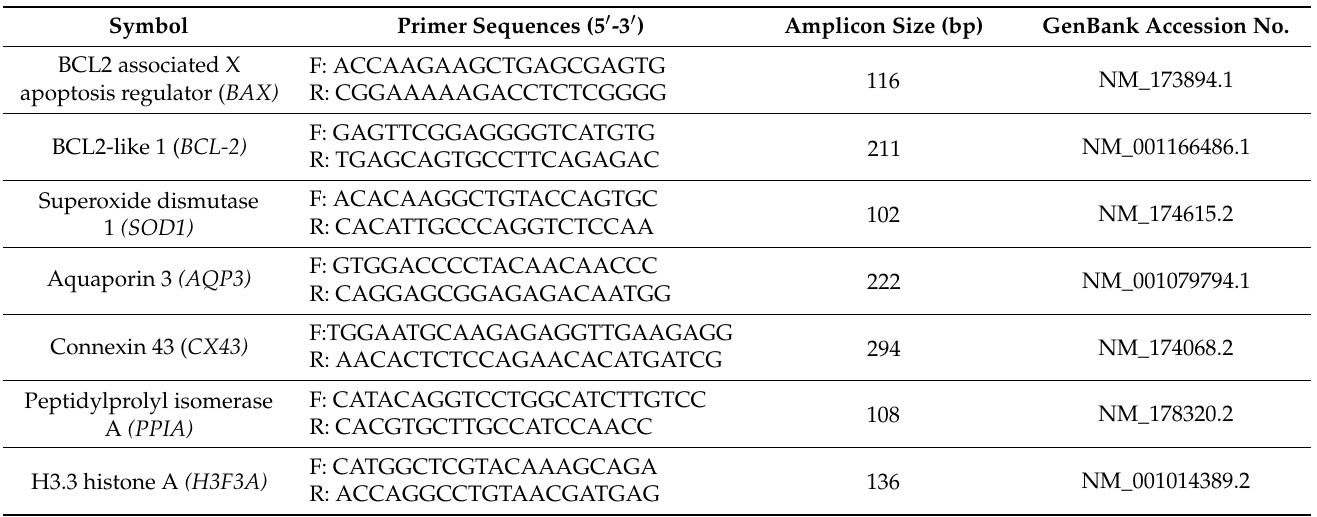
Table 5. Primers used for reverse transcription-quantitative polymerase chain reaction (rt-qPCR) (NCBI, National Center for Biotechnology